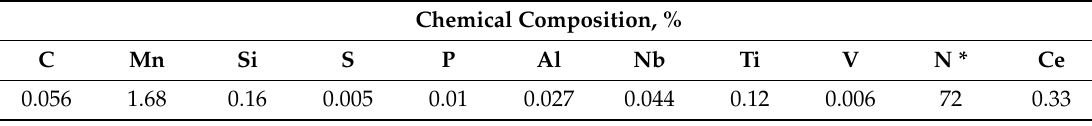
Table 1. Actual chemical composition of original steel S700 MC.